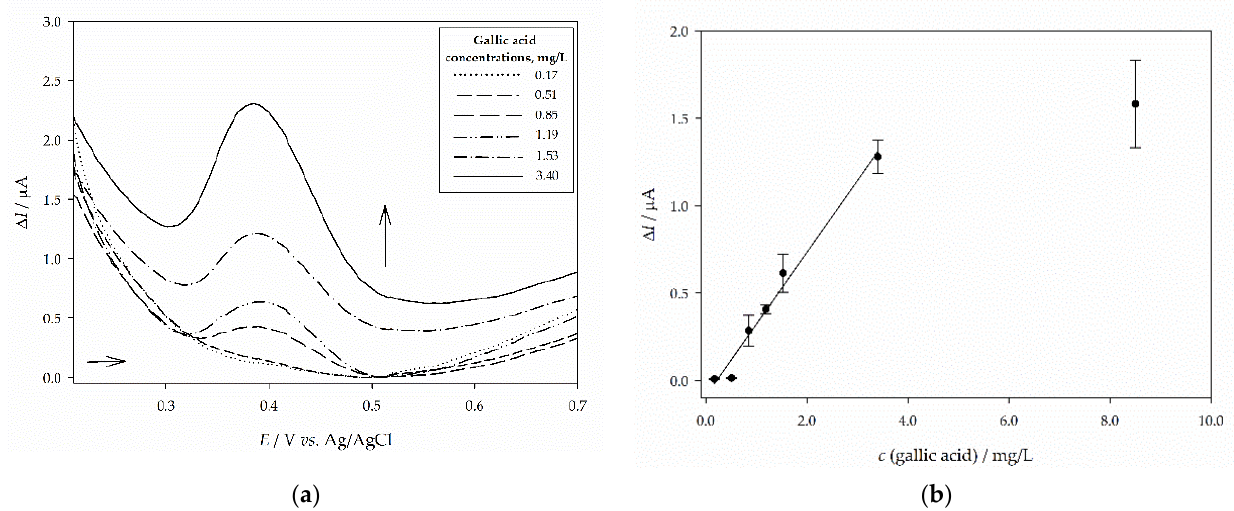
Figure 5. Experimental analysis of polyphenolic standard gallic acid: ( a ) square-wave voltammograms (SWV) obtained on the surface of glassy carbon electrode (GCE) and immersed in Britton Robinson buffer (pH 2.5) for concentration range 0.17–3.40 mg/L; ( b ) dependence of the net peak currents on the concentration of gallic acid with the linear regression line. The frequency is 10 Hz, pulse amplitude is 50 mV, and the step potential is 2 mV.